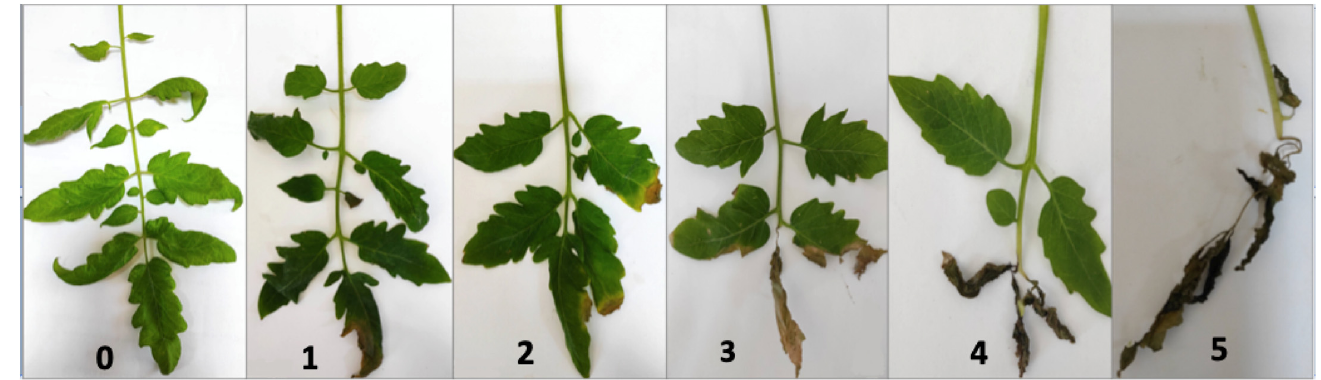
Figure 1. The 0–5 disease severity scale: 0 = no symptoms, 1 = 0–11% symptoms, 2 = 11–25% symptoms, 3 = 25–50% symptoms, 4 = 50–75% symptoms, and 5 = 75% dead compound leaves. Plant defense elicitor treatments : FytoSol was kindly obtained from FytoFend SA, Bel- gium. FytoSol was directly dissolved in distilled water until 0.5% concentration and used